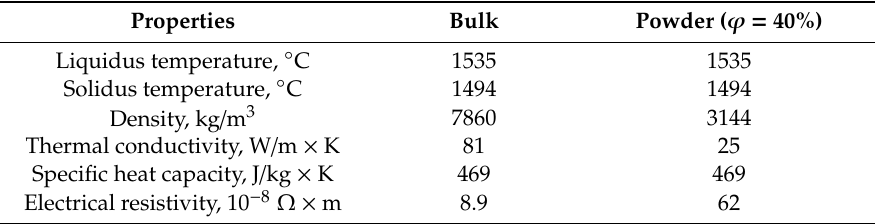
Table 1. Physical properties of an AISI 1008 alloy [35,36].